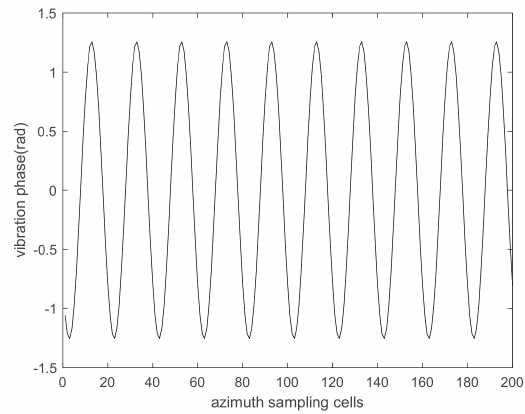
Figure 6. Fixed amplitude vibration phase.